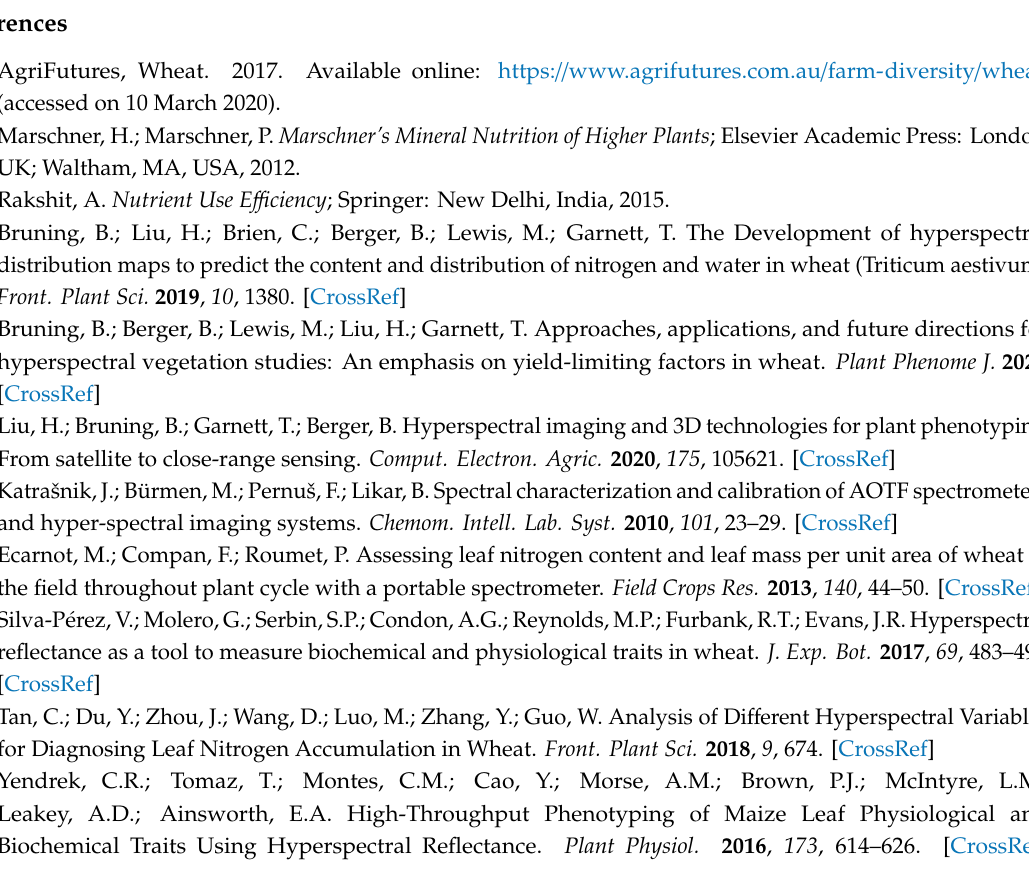
changing to blue.